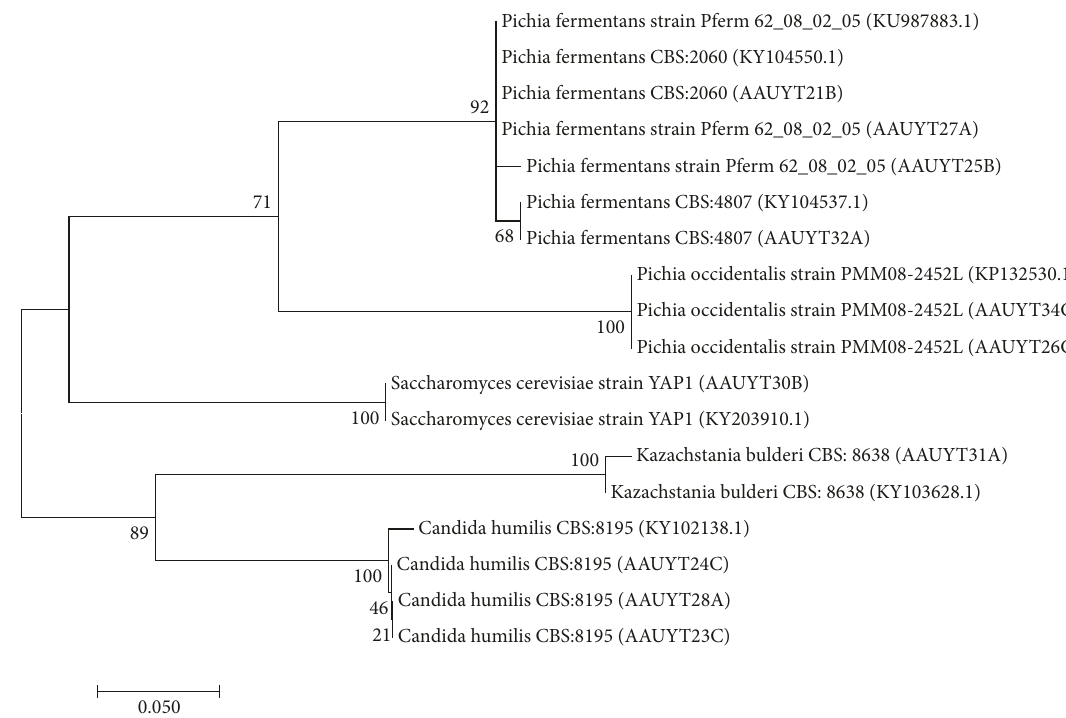
Figure 2: Phylogenetic tree of 13 yeast isolates from fermented teff dough using ITS DNA sequence. i.e., 13 yeast isolates were (AAUBT21B, AAUBT25B,AAUBT27A,AAUBT28A, AAUBT24C, AAUBT23C,AAUBT31A, AAUBT26C,AAUBT34C, AAUBT32Aand AAUBT30B)and 9 yeast accessions were from GenBank (KY102138.1, KY104888.1, KY104550.1, KU987883.1, KY103628.1, and KY102138.1 AND